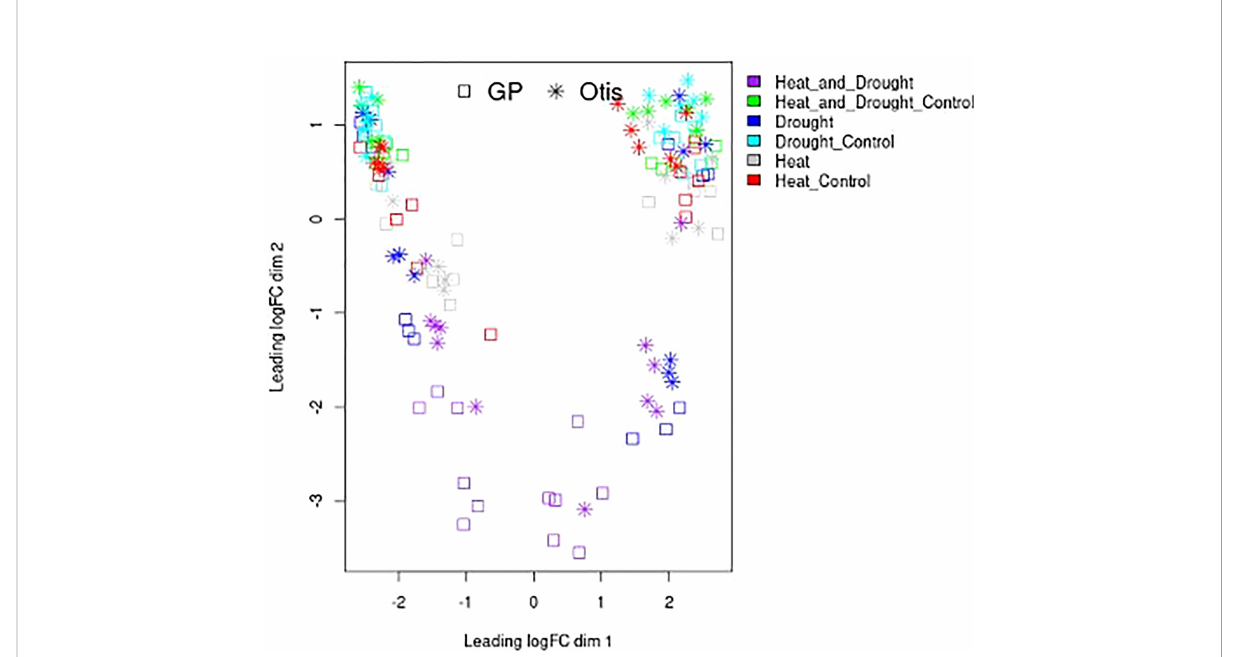
FIGURE 4 Multidimensional scaling plot of replicated RNA-Seq samples. Features on the plot represent libraries of control, drought, heat and combined stress treatments from fl ag leaves and head tissues collected after 1 day and 5 days of treatment. Spatial arrangement of the various RNA-seq libraries is based on their calculated distances estimated using root-mean-square deviation for the top 500 genes with the largest standard deviation among all samples. The square represents GP libraries while the * represent Otis libraries. The color code for the heat, drought and combined heat and drought and corresponding controls is shown on the